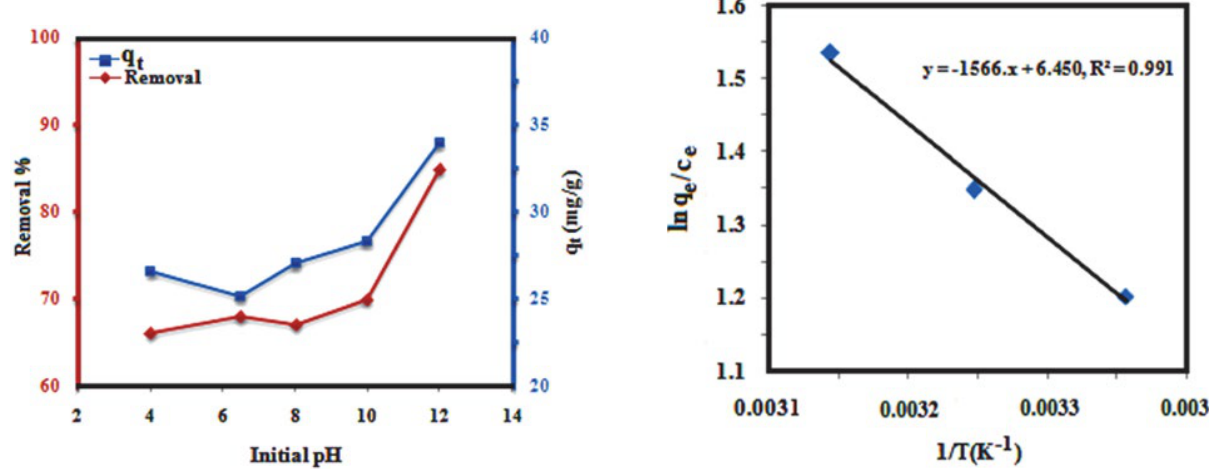
Figure 14. Effect of initial pH on adsorption capability and removal of MB with GO/Co